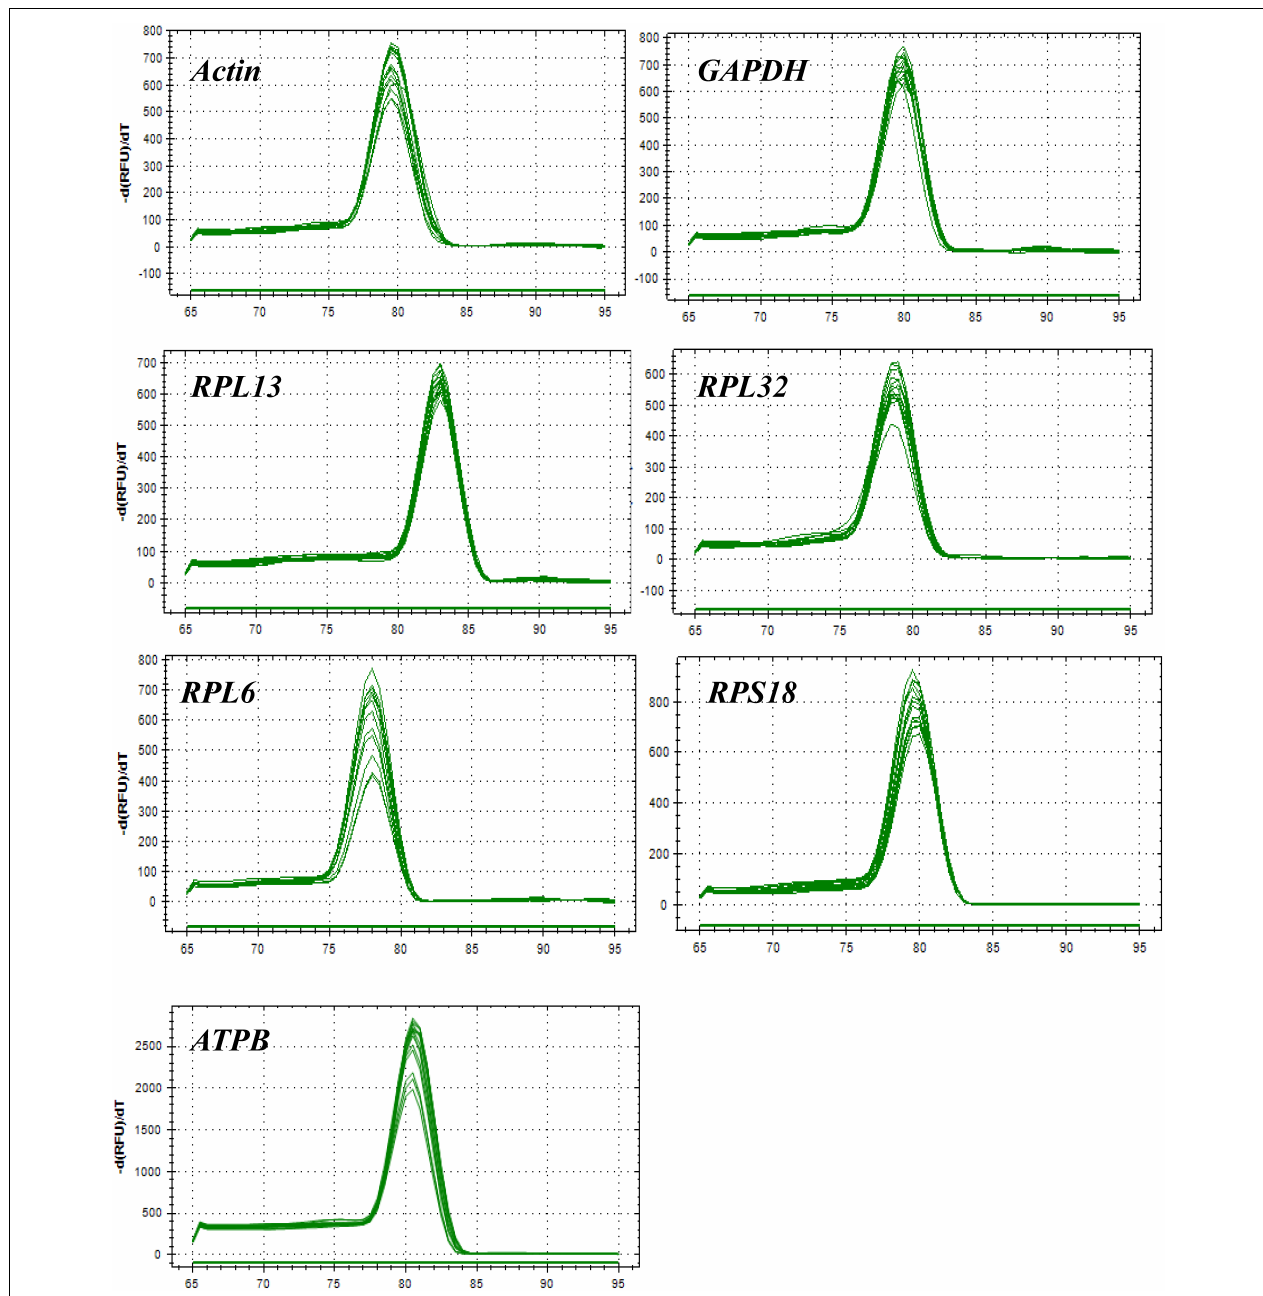
FIGURE 1 | Melting curves of the 7 candidate reference genes in H. vigintioctomaculata .